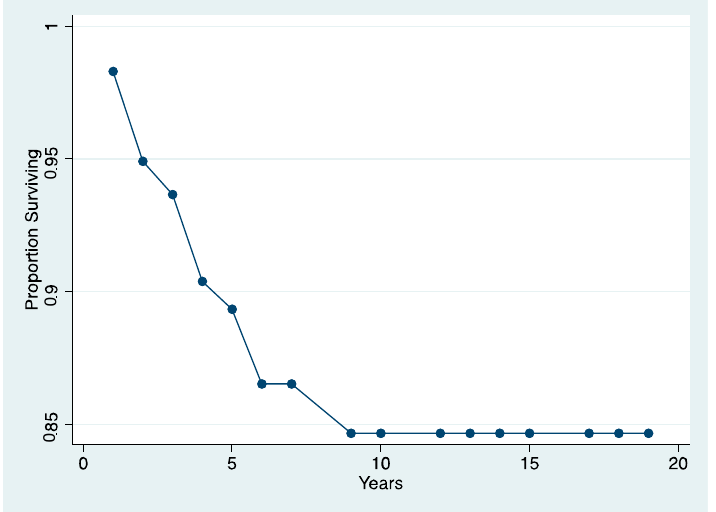
Figure 5. The cumulative survival to any complication displays that they occurred in the vast majority during the first 5 years of service. Notwithstanding, after 18 years of observation, the success rate was 92.6% (IC 90.1–94.71). Table 1. Considered independent variables. (FullC = full crown; FilQuality = quality of endodontic filling; Symt = presence of symptoms; Seal = quality of restoration